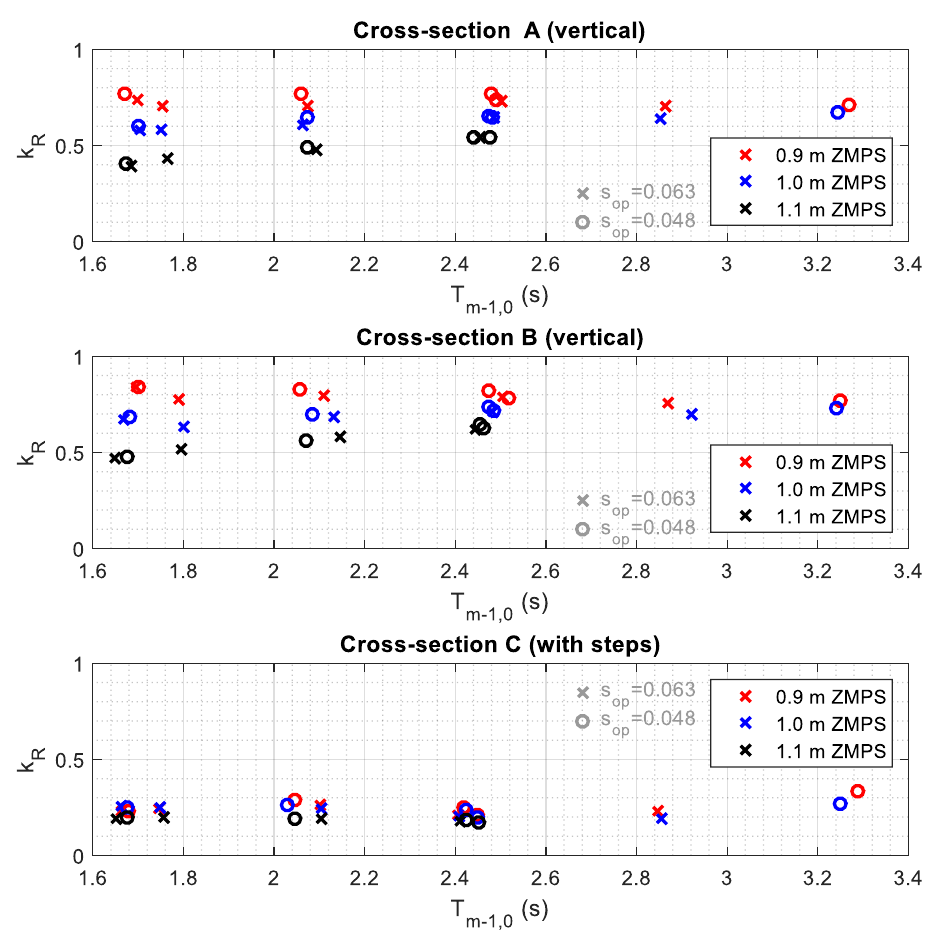
Figure 8. Wave reflection coefficient for the three cross-sections, from top to bottom: type A , B and C .